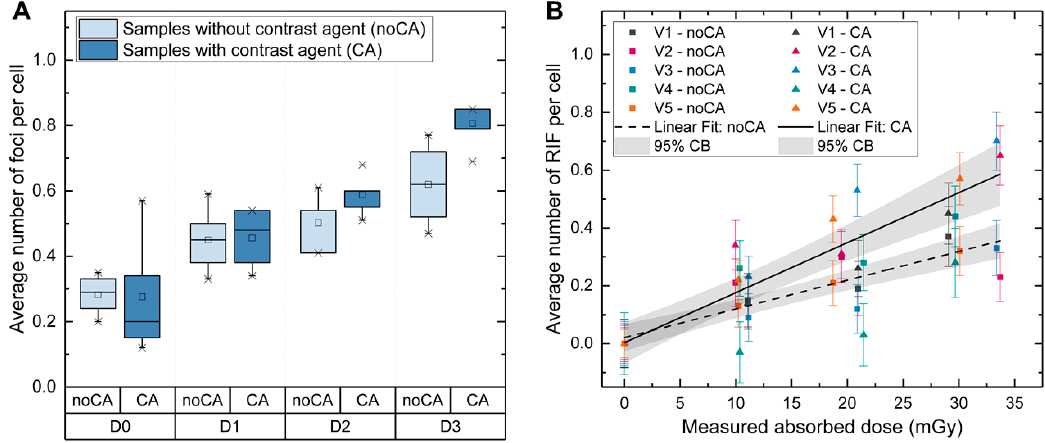
Figure 4. Ex vivo study—absorbed dose- and contrast agent-dependency of the average number of foci and RIF. ( A ) Boxplot of the average number of foci per cell after ex vivo irradiation with different CT settings resulting in the absorbed doses D0 (no irradiation), D1 (10.6 ± 0.5) mGy, D2 (20.3 ± 1.1) mGy and D3 (31.2 ± 2.1) mGy. ( B ) Average number of RIF per cell as a function of the measured absorbed dose for the five volunteers V1-V5 with linear fits including 95% confidence bands.